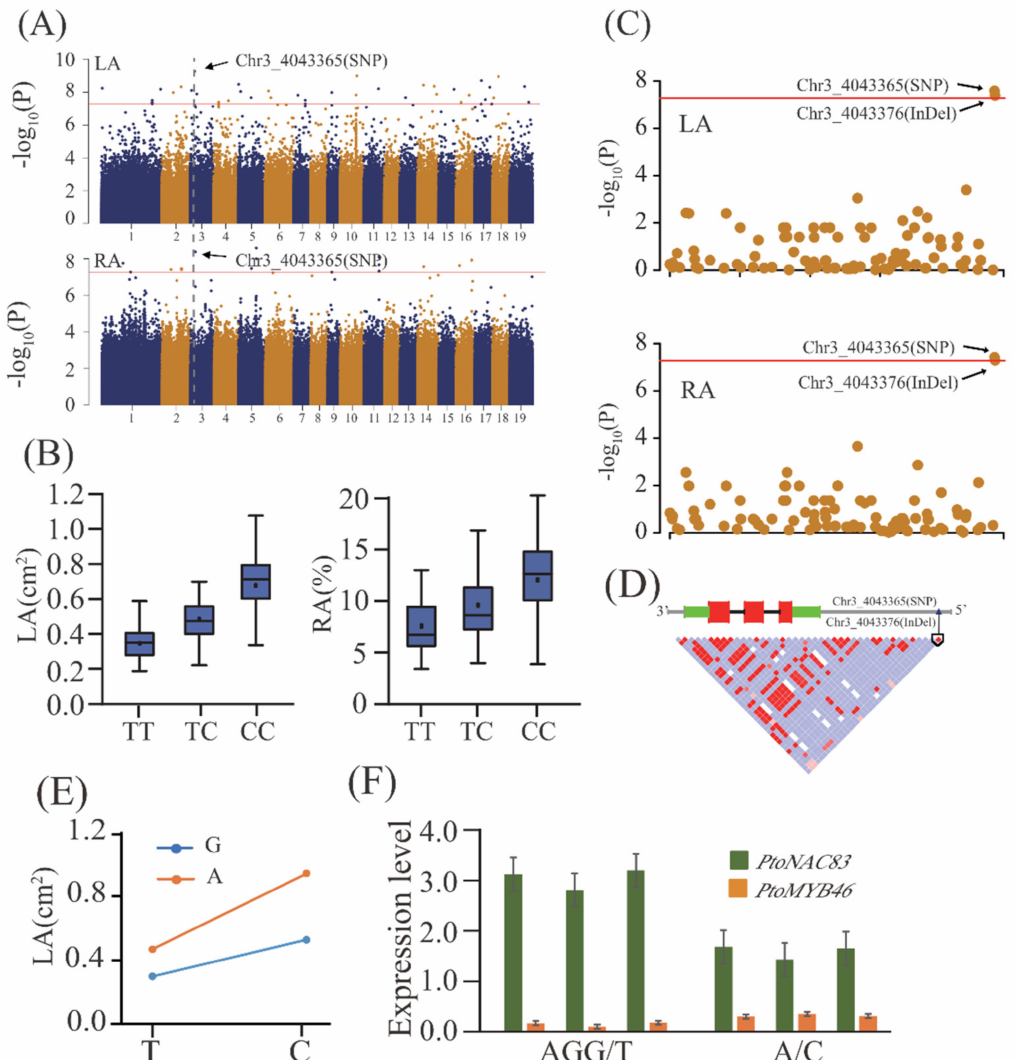
Figure 2. PtoNAC83 is an important genetic regulator that contributes to lenticel area (LA) and the ratio of the total LA to the area of a standard rectangular sampling window (RA) in Populus tomentosa . ( A ) Manhattan plots of GWAS results for all single nucleotide polymorphisms (SNPs) versus LA and RA. The horizontal red line represents the significance threshold ( − log 10 P > 7.27425). The arrow indicates the signal containing the candidate genes. ( B ) Box plot of SNP genotype effects of Chr3_4043365 on LA and RA. ( C ) Manhattan plots of candidate genes associated with genetic markers (SNPs and InDels) versus LA and RA. ( D ) Gene structure diagram and linkage disequilibrium (LD) heatmap (bottom) of PtoNAC83 . Green, red, black, and gray represent non-coding, exon, intron, and intergenic regions, respectively. ( E ) Epistatic effects between Chr3_4043365 and Chr9_3551378 underlying LA. The C allele (Chr3_4043365) depends on the A allele (Chr9_3551378) in increasing LA. (F) Genotype effects of haplotype on PtoNAC83 and PtoMYB46 expression. Data are presented as means ± SE (n =